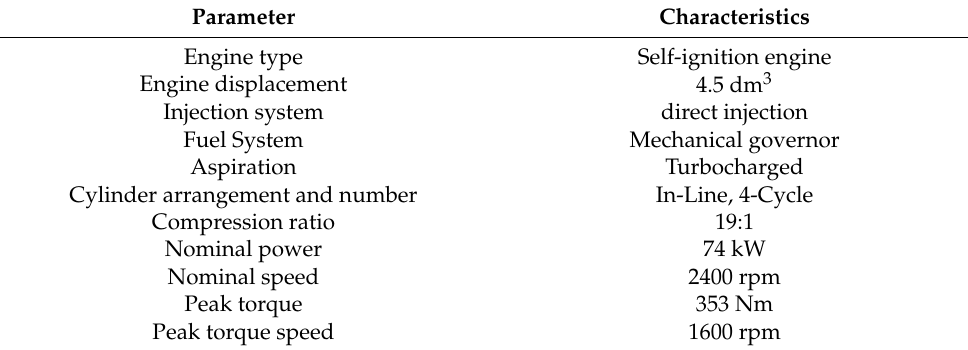
Table 3. Chosen parameters of the John Deere 4045TF285JD engine.